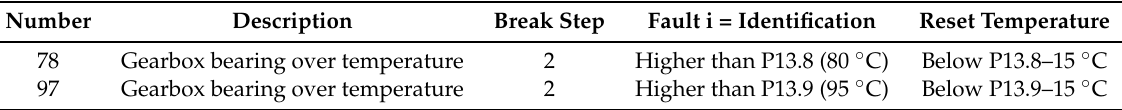
Table 2. Overtemperature fault log of gearbox